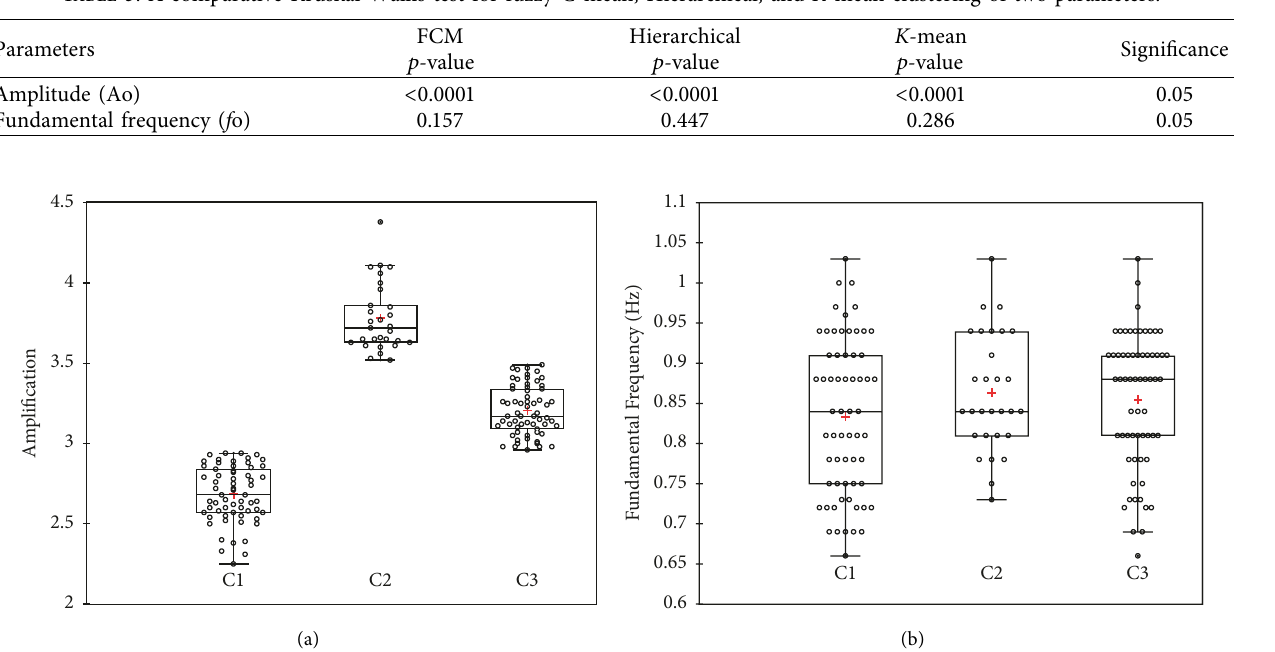
Table 3: A comparative Kruskal-Wallis test for fuzzy C-mean, Hierarchical, and K -mean clustering of two parameters.